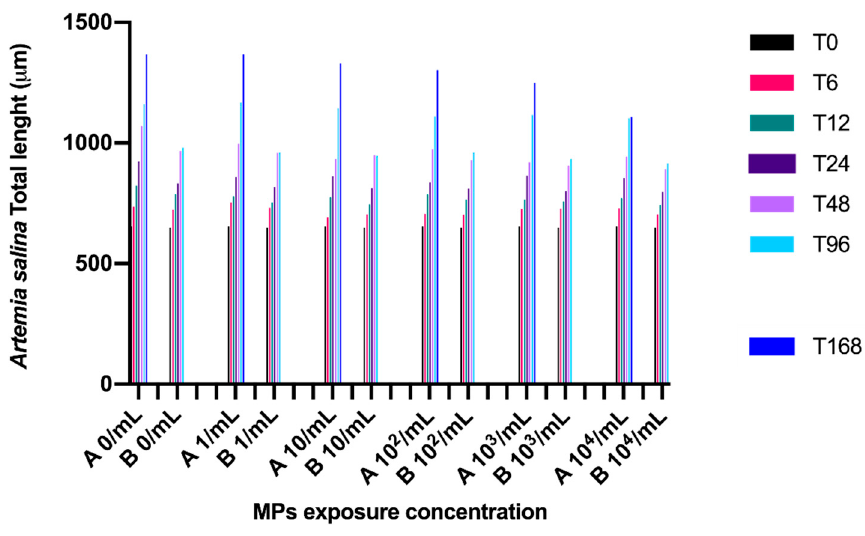
Figure 4. Artemia salina total body length at each concentration and experimental time. MPs concentration less influenced total body length within the Group B, showing at T96 a difference of 66 µ m comparing B0 (981.26 µ m) with B5 (915.164 µ m), but